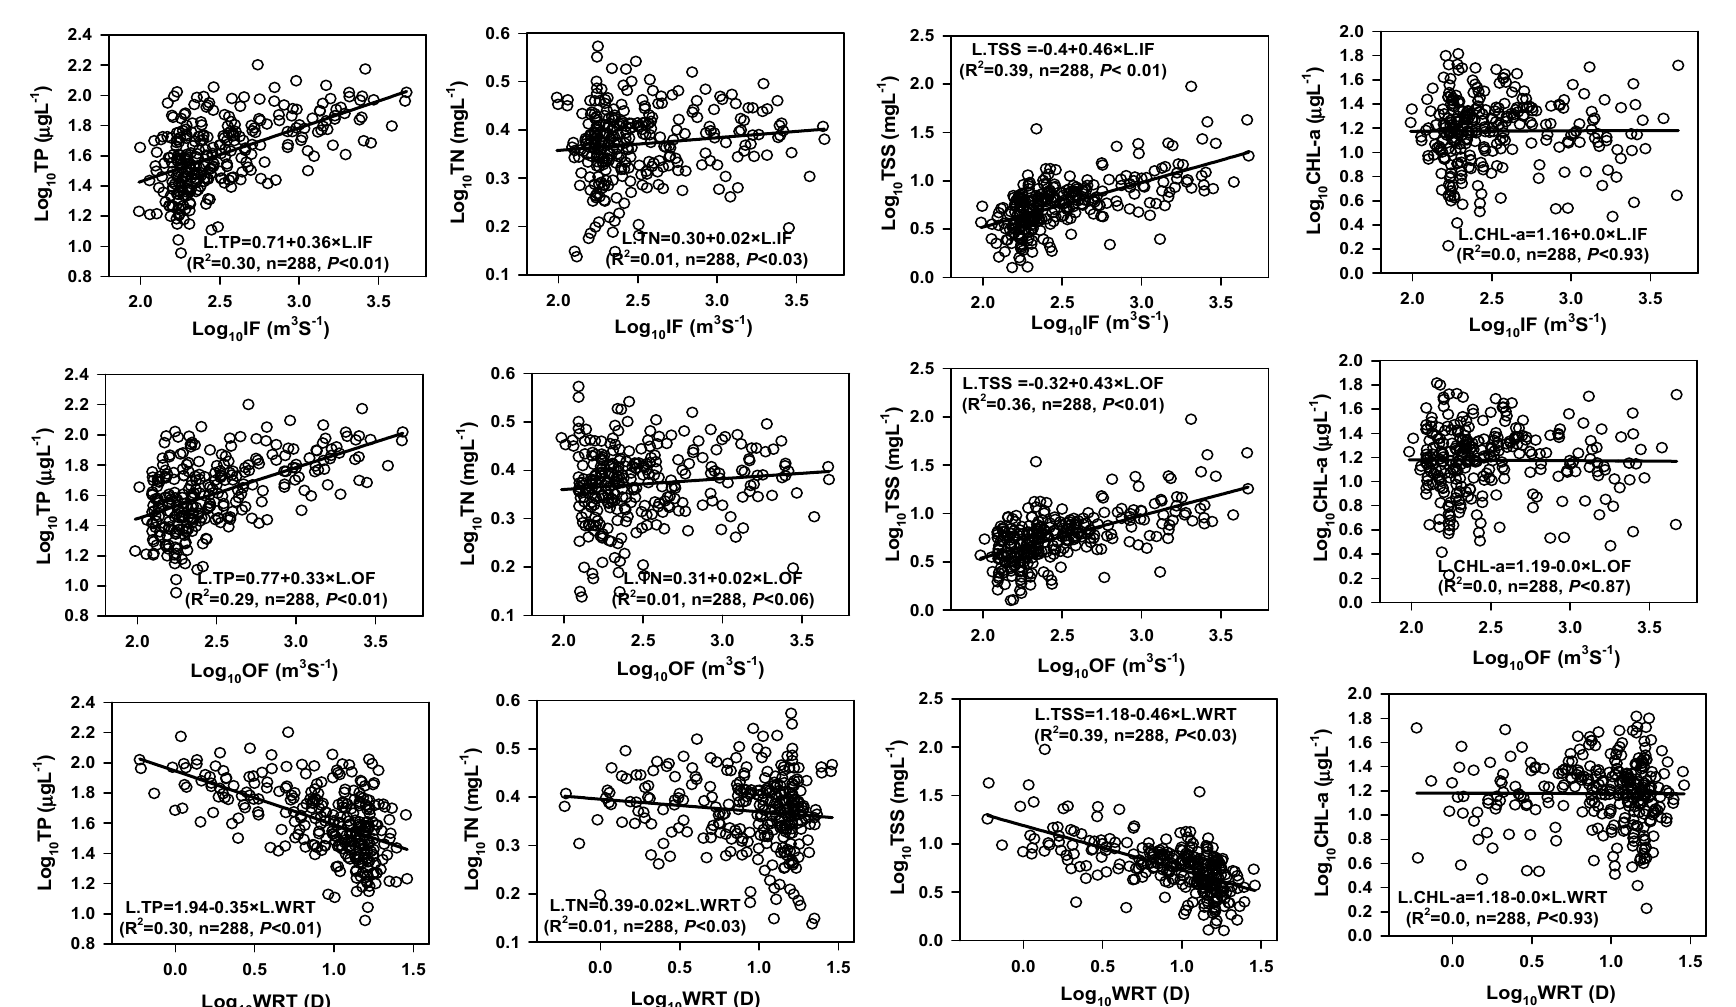
Figure 3. Influence of hydrology on TP, TN, TSS, and CHL-a. TP—total phosphorus, TN—total nitrogen, TSS—total suspended solids, CHL—chlorophyll-a.